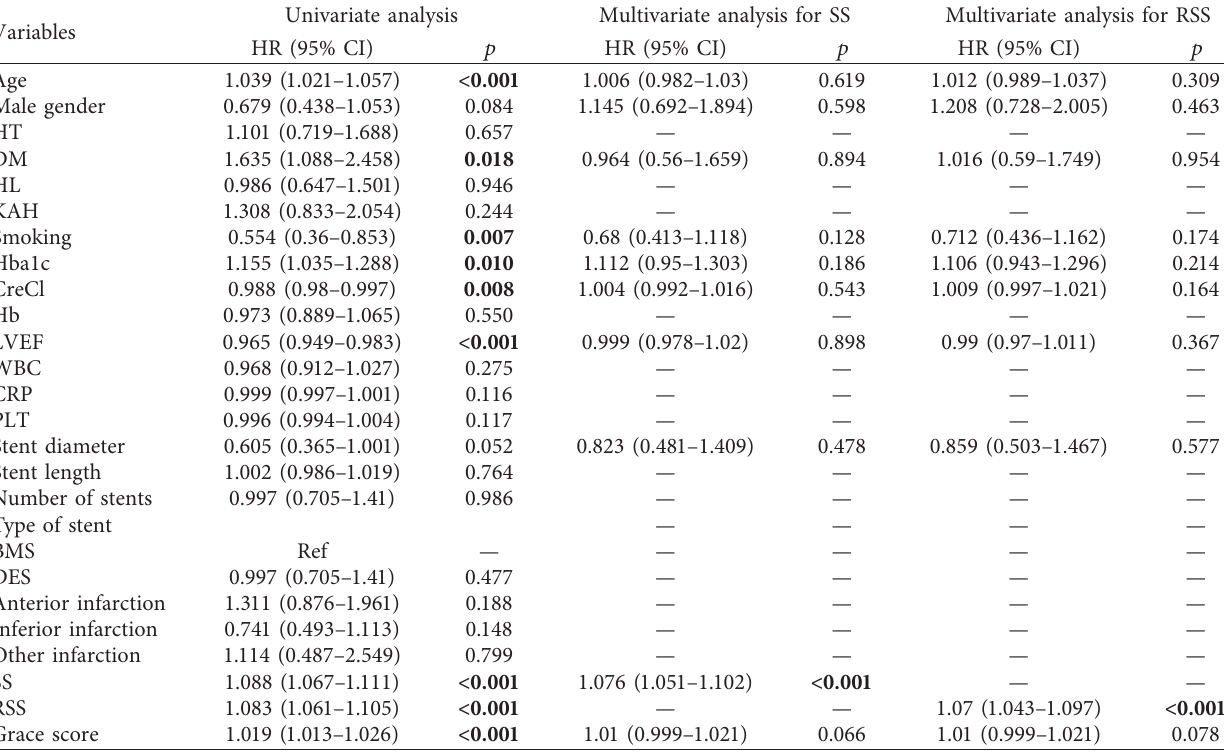
Table 6: Univariate and multivariate cox regression analysis for determining the risk factors associated with long-term MACE. Univariate analysis Variables